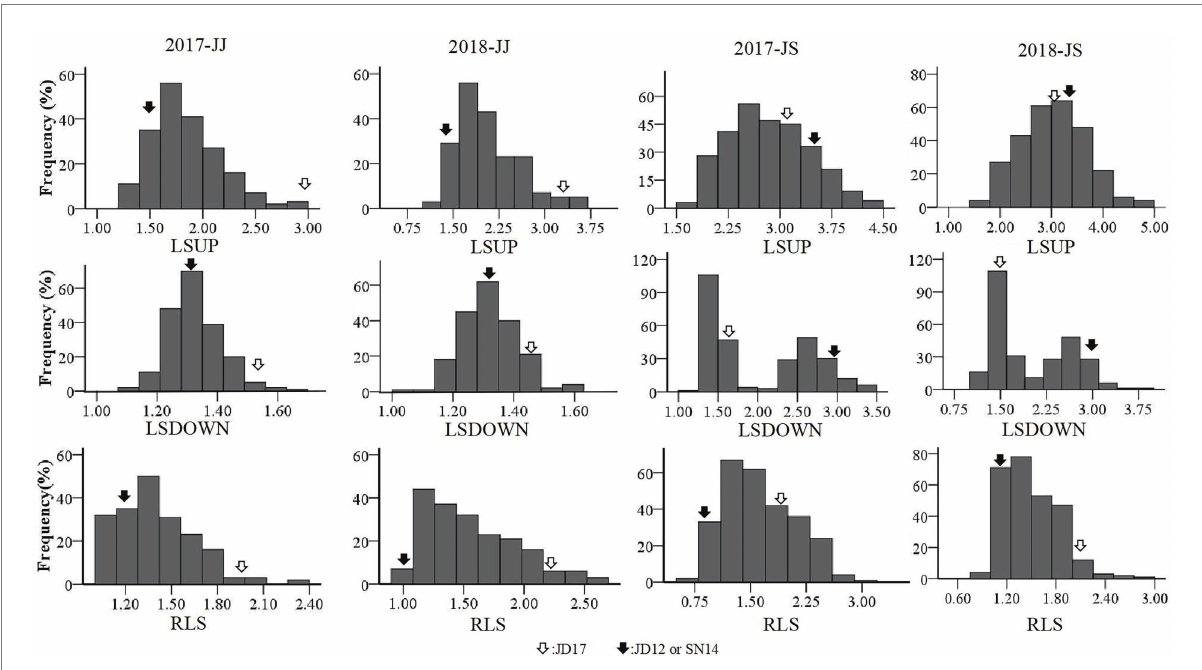
FIGURE 2 Frequency distributions of leaf-related characteristics obtained from the two RIL populations in the two cropping